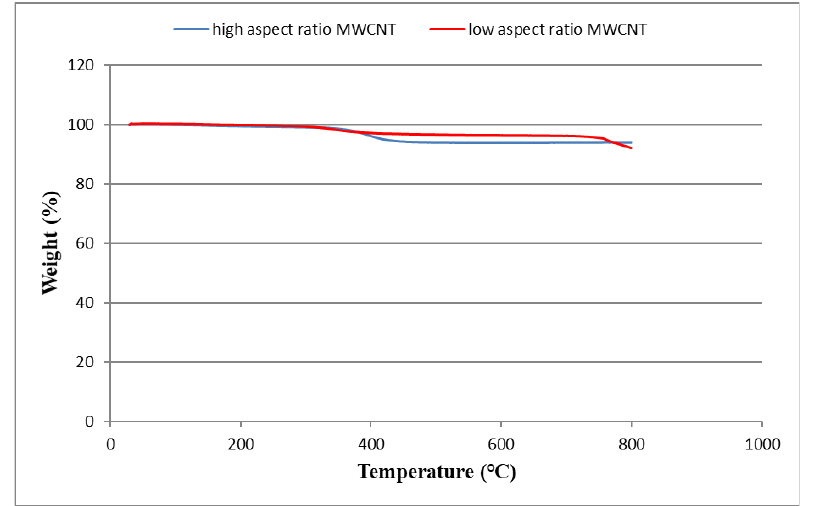
Figure 7. Residual weights of buckypapers composed of high and low aspect ratios MWCNTs in the thermogravimetric analyzer (TGA) test.